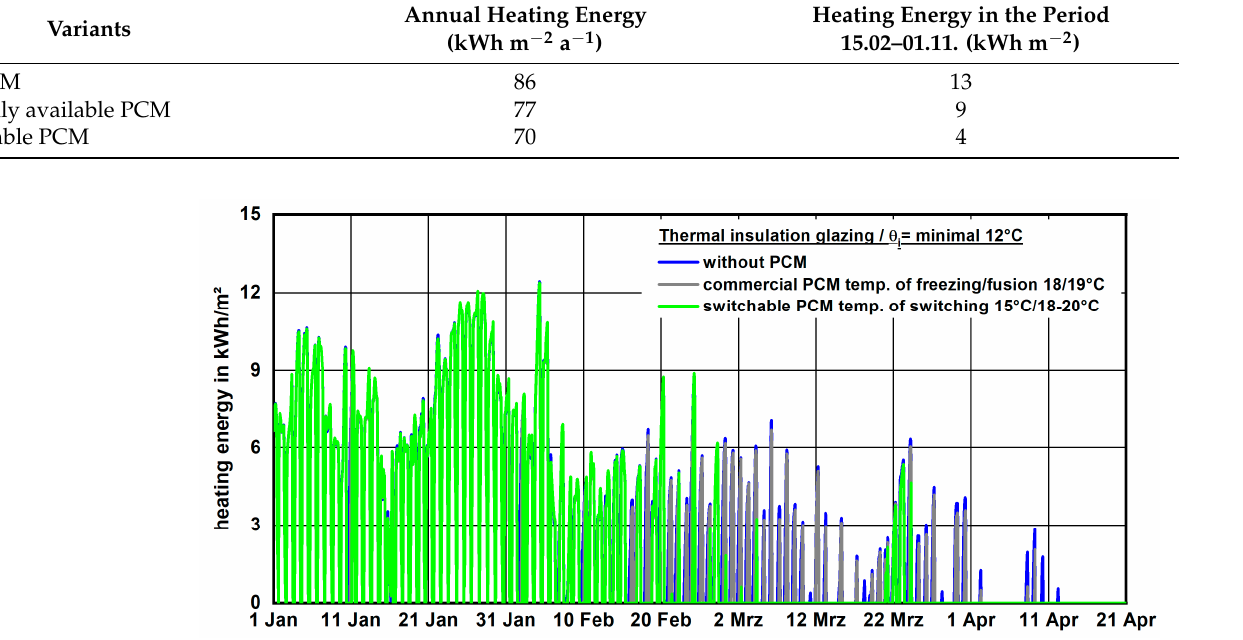
Figure 10. Comparison of the required heating energy for the period from 1 January to 21 April when using thermal insulation glazing without a PCM (blue), with a commercially available PCM (gray), and with a newly developed, programmable PCM (green).